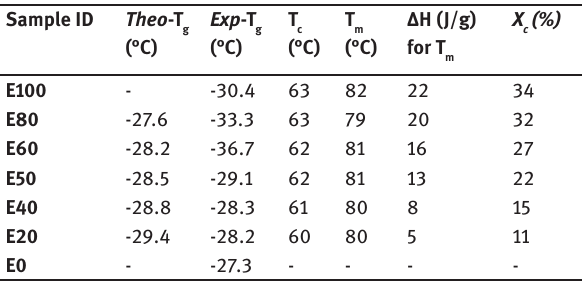
cooling curves. , T , and T characteristics of pristine NBR, EMA and NBR Table 2: T g c m EMA